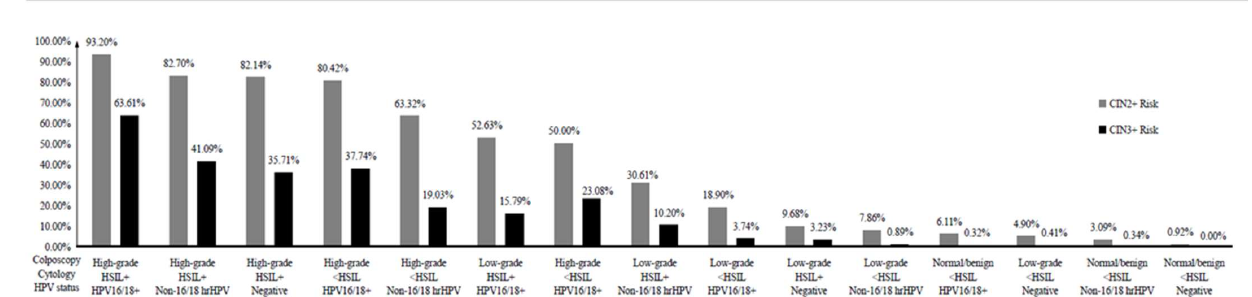
Figure 1. The sequence of cervical precancer risk strata based on colposcopy cytology and HPV status. Abbreviations: CIN2+, cervical intraepithelial neoplasia grade 2 or worse; CIN3+, cervical intraepithelial neoplasia grade 3 or worse; <HSIL, includes negative for intraepithelial lesion or malignancy (NILM), atypical squamous cells of undetermined significance (ASC-US), low-grade squamous intraepithelial lesion (LSIL); HSIL+, high-grade squamous intraepithelial lesion or worse; HPV, human papillomavirus; hrHPV, high-risk HPV.